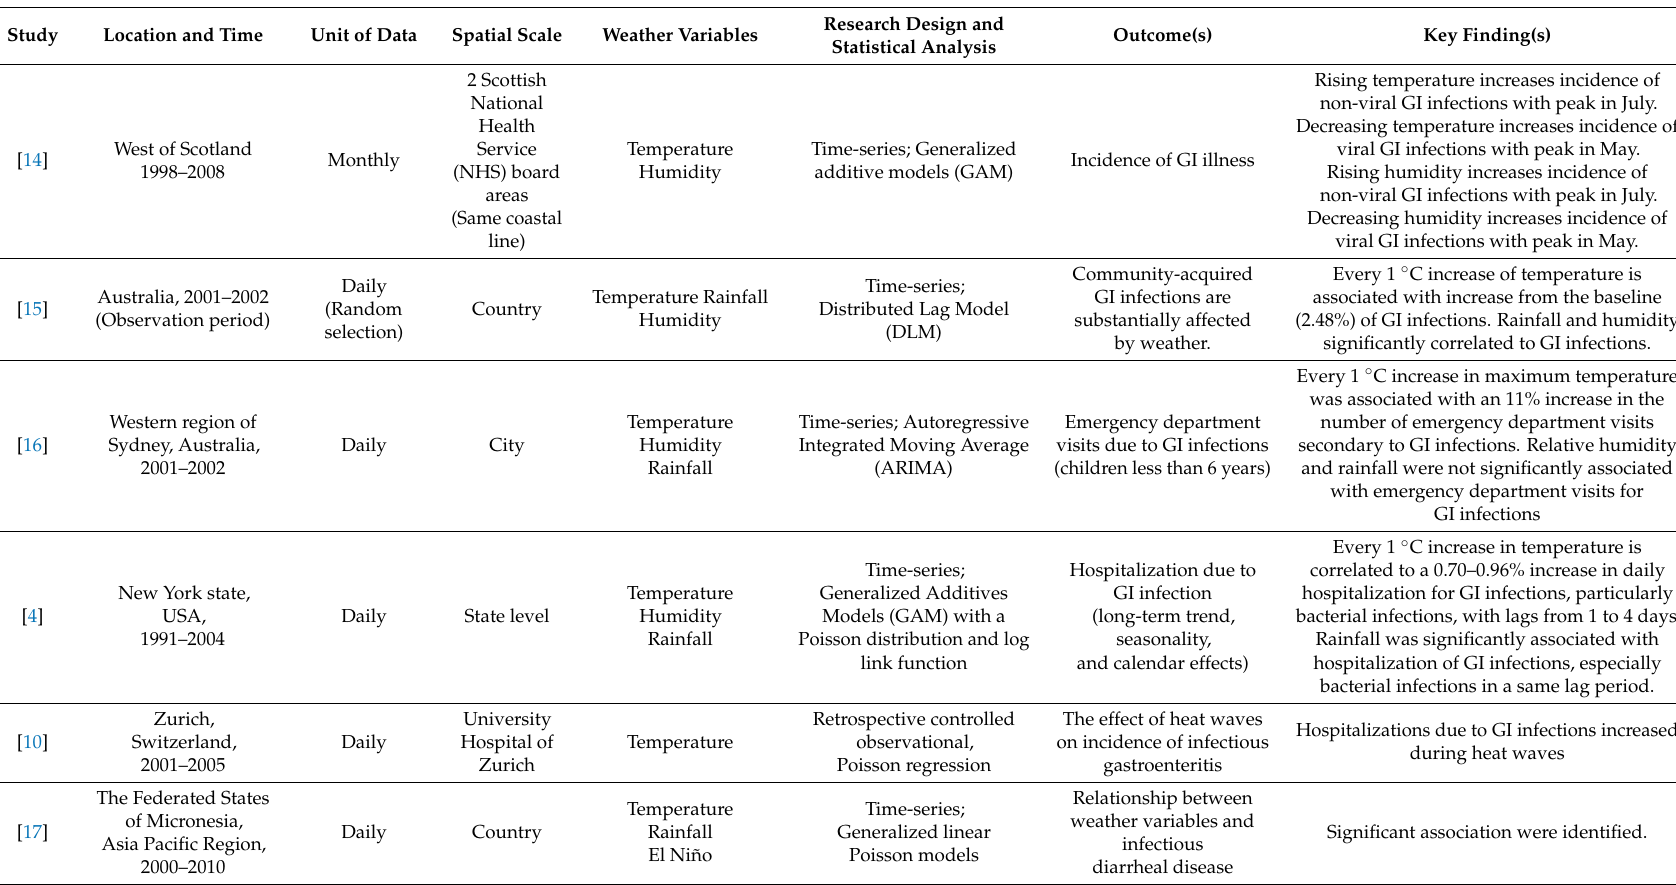
Table 1. Characteristics of studies about weather variables and gastrointestinal (GI)